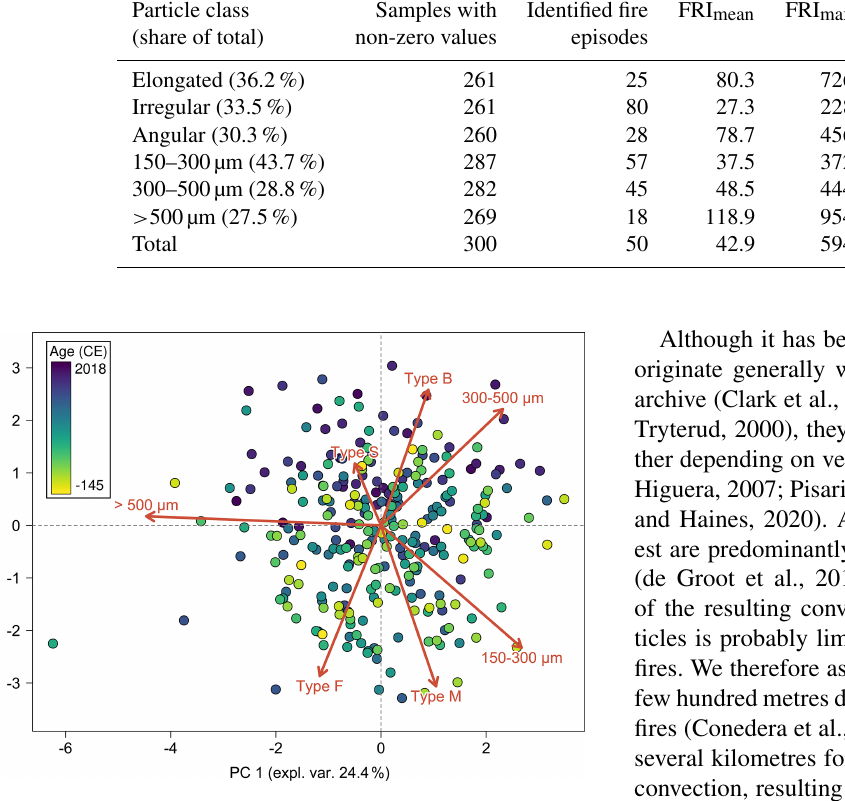
Figure 4. Principal component analysis (PCA) of charcoal parti- cles (size classes and individual morphotypes with a share of > 5% of the charcoal record), with coloured dots representing potential grouping patterns of charcoal assemblages with increasing